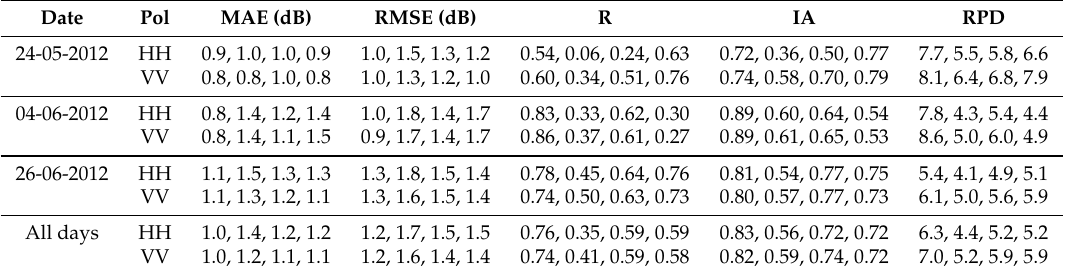
Table 6. Statistical parameters in estimating the backscattering coefficients of HH and VV polarization (Pol) using four different combined models (MWC-EM, WC-GOM, MWC-GOM,